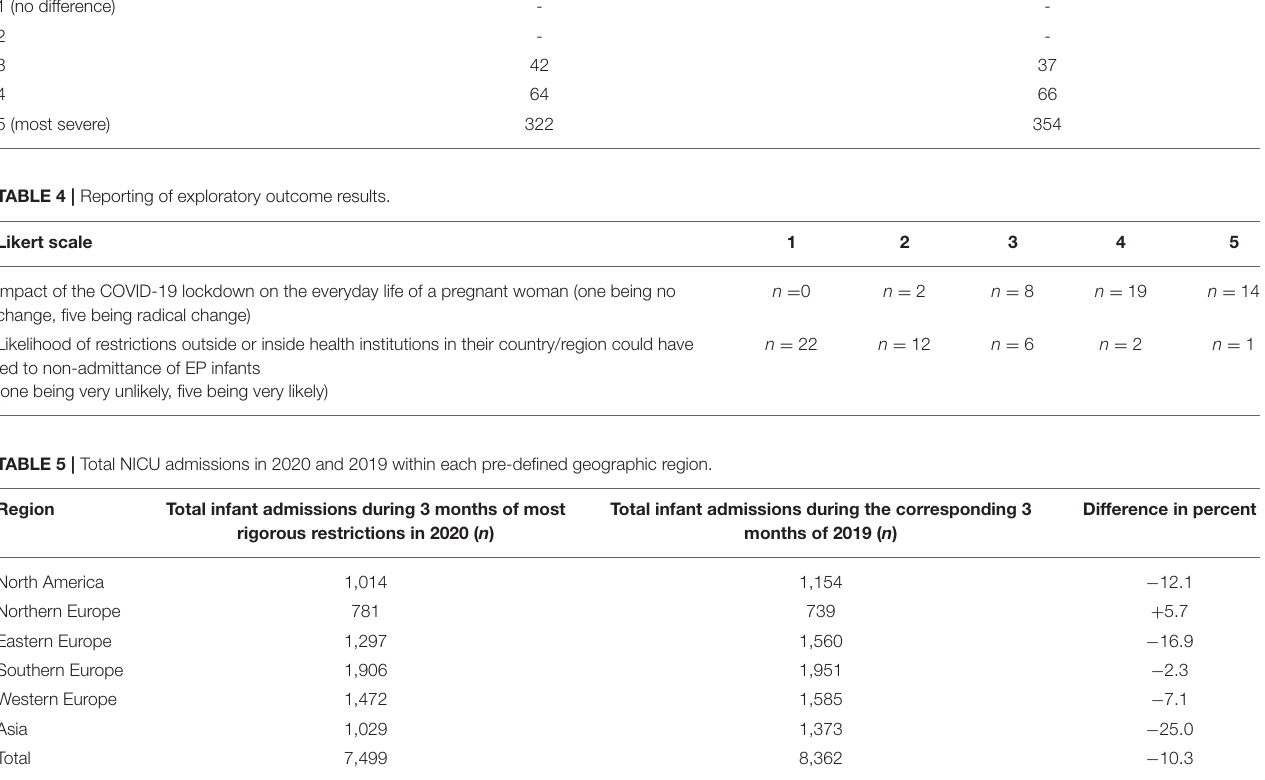
TABLE 3 | Number of EP infant admissions in 2020 and 2019 stratified by level of lockdown restriction. Level of lockdown restrictions